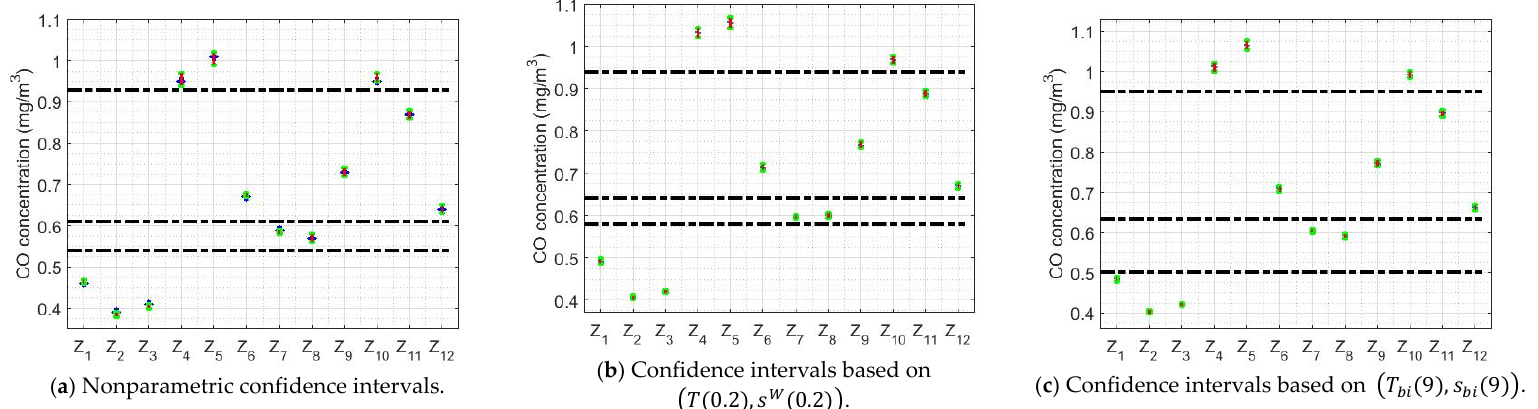
Figure 13. 95% confidence intervals for the groups of every two hours of the day: (cid:1852) (cid:2869) (0:00–1:00) , (cid:1852) (cid:2870) (2:00–3:00) , (cid:1852) (cid:2871) (4:00–5:00) , (cid:1852) (cid:2872) (6:00–7:00) , (cid:1852) (cid:2873) (8:00–9:00) , (cid:1852) (cid:2874) (10:00–11:00) , (cid:1852) (cid:2875) (12:00–13:00) , (cid:1852) (cid:2876) (14:00–15:00) , (cid:1852) (cid:2877) (16:00–17:00) , (cid:1852) (cid:2869)(cid:2868) (18:00–19:00) , (cid:1852) (cid:2869)(cid:2869) (20:00–21:00) , and (cid:1852) (cid:2869)(cid:2870) (22:00–23:00) .